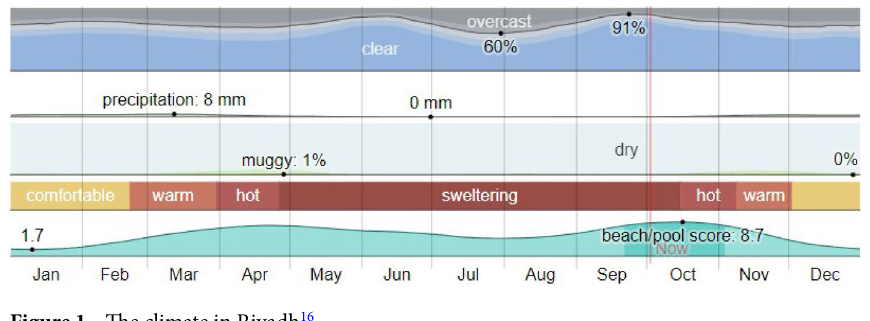
Figure 1. The climate in Riyadh 16